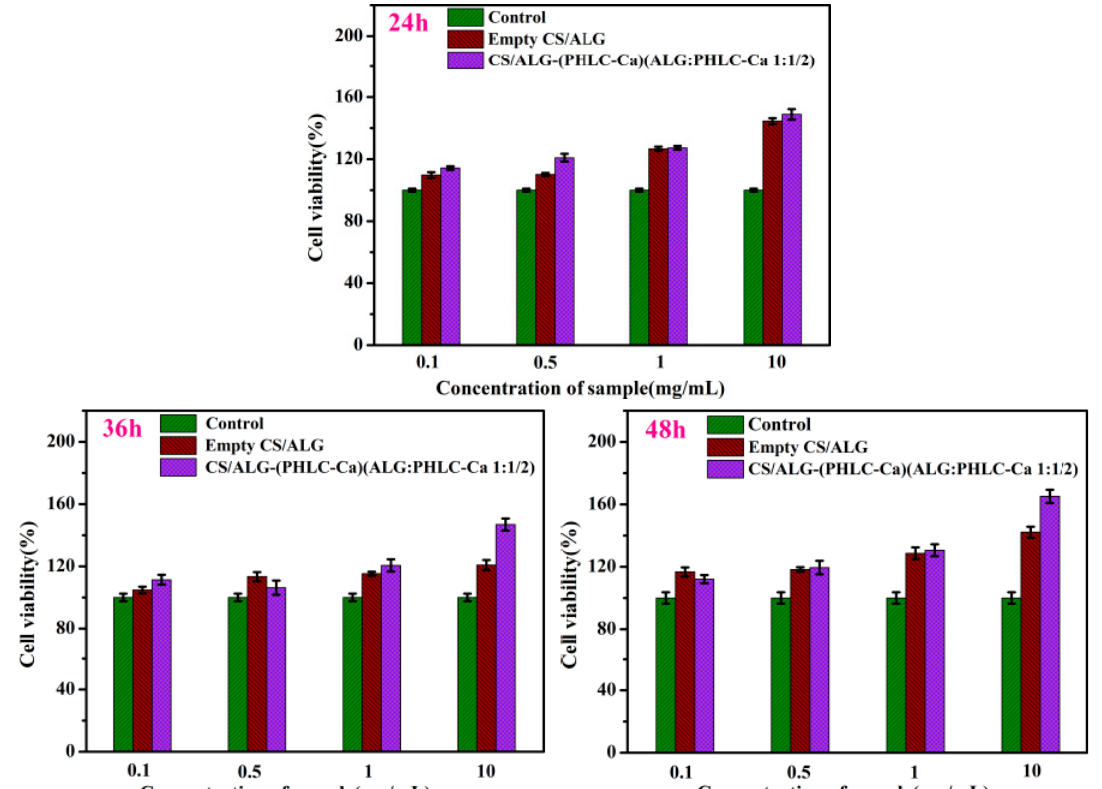
Figure 7. Proliferation graph of the mouse L929 fibroblast cells cultured with different concentrations of microcapsules extracts for 24, 36 and 48 h, analyzed by the MTT assay.